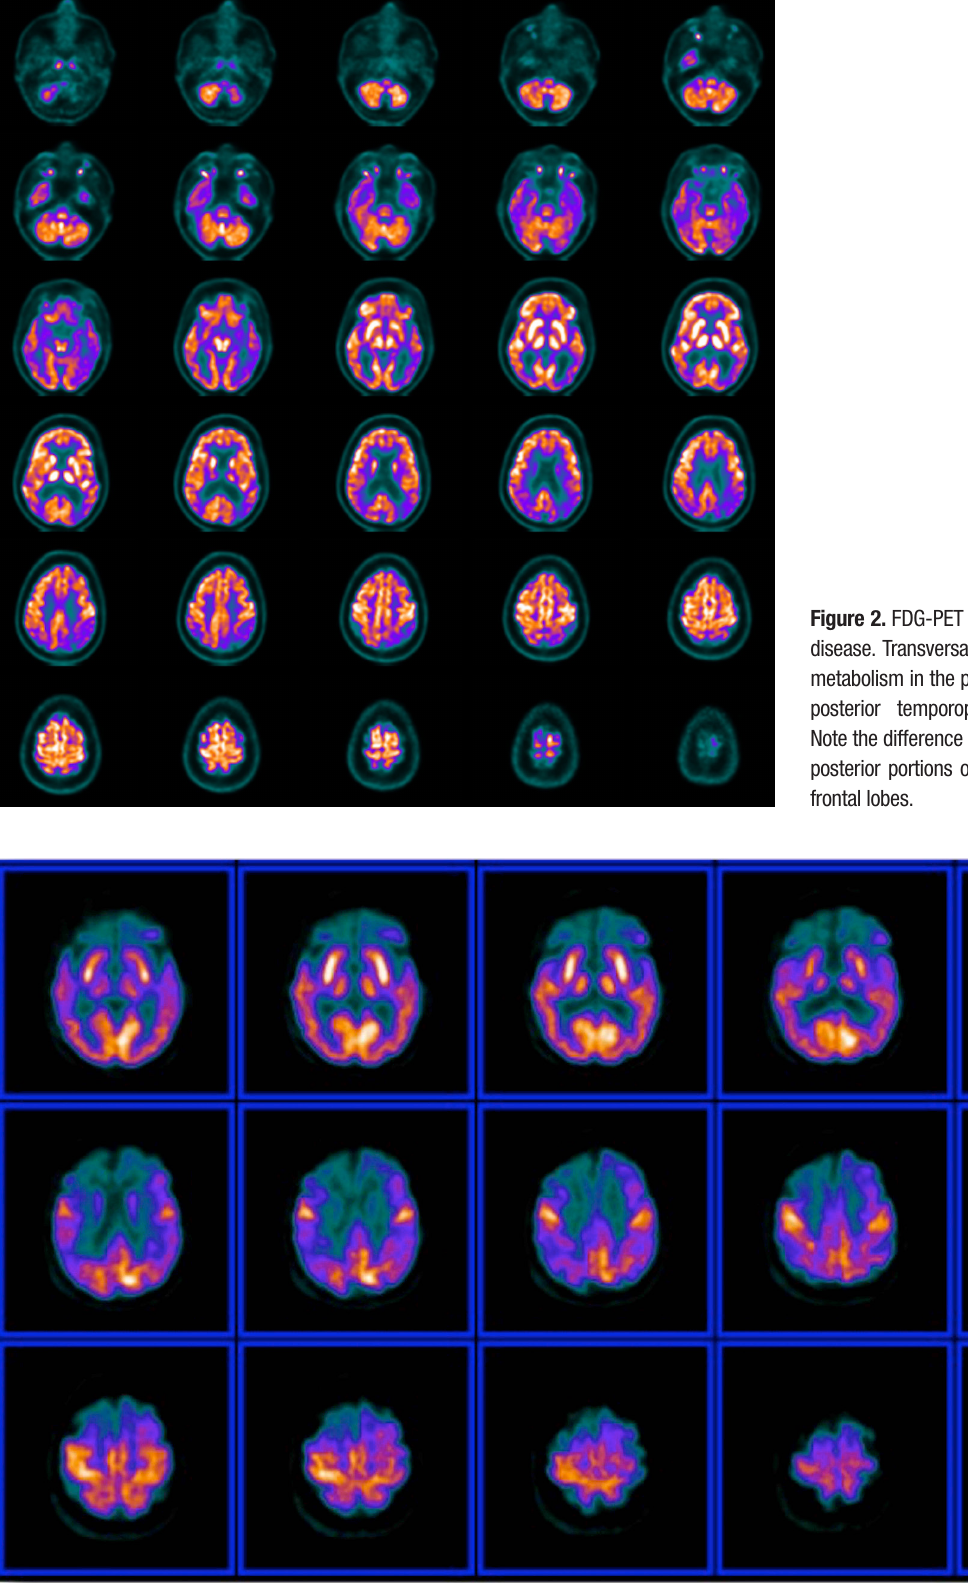
Figure 3. Example of an advanced case of Alzheimer’s disease. Note progression of the metabolic posterior temporoparietal impairment towards the frontal lobes, with spared motor and visual cortices